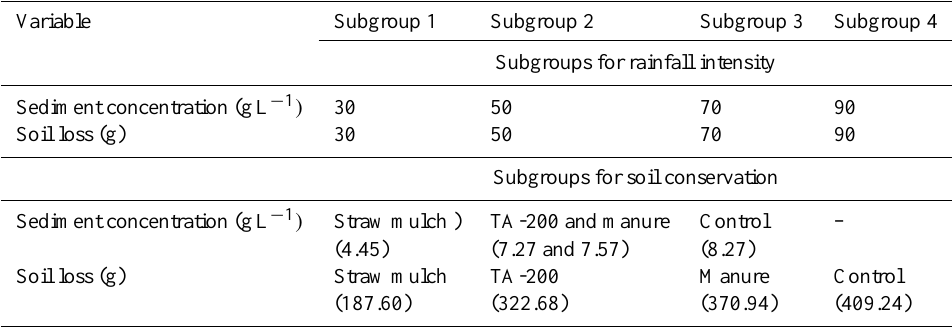
Table 5. Determination of significant differences between rainfall intensities and soil conservation treatments using post-hoc analysis (Dun- can